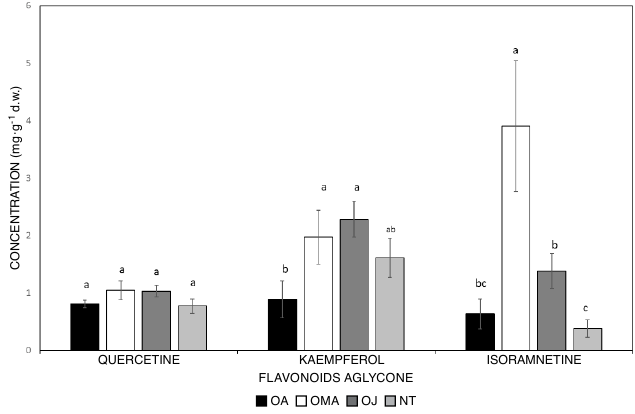
Fig. 2: Flavonoid content in four nopal cultivars. Values represent the mean ± standard deviation of 3 replicates. Bars with different letters for the same fl avonoid aglycone indicate statistically signifi cant differ- ence by Tukey’s test (p < 0.05). Abbreviations: dw = dry weight; NT = N. cochellinifera cv. Texas; OJ, OA, and OMA = O. fi cus-indica cv. Jade, Atlixco, and Milpa Alta,